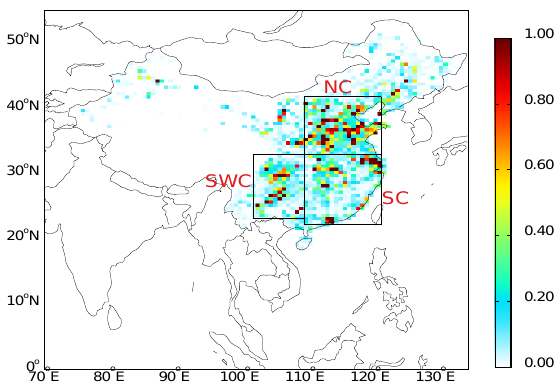
Figure 1. SO 2 emissions from China in the year